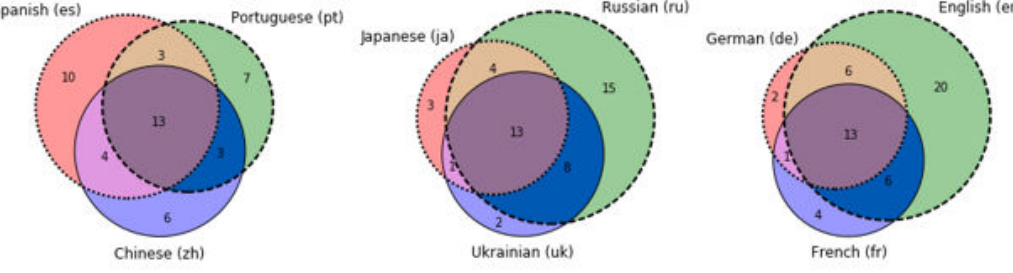
Figure 5. Venn diagram of sets of cryptocurrency-related articles in selected editions of Wikipedia. See http: // data.lewoniewski.info / crypto / for interactive version.